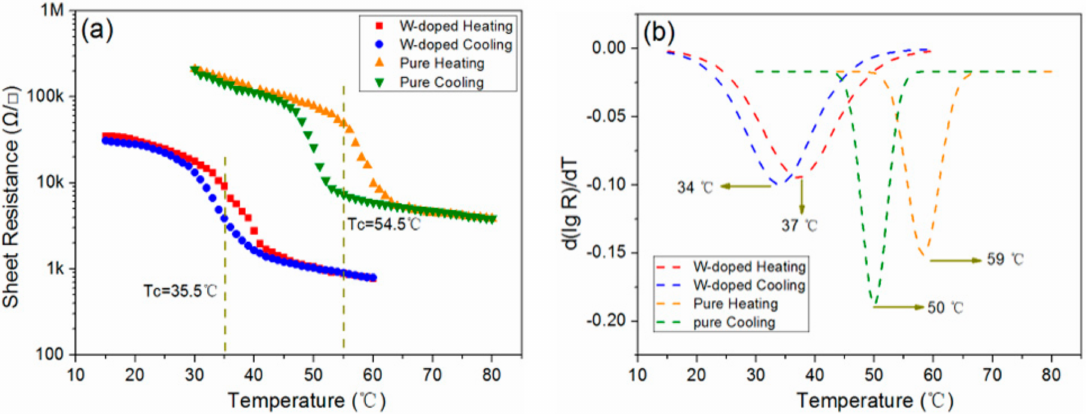
Figure 7. ( a ) Resistance–temperature hysteresis loops and ( b ) phase-transition temperatures of the pure and W-doped VO 2